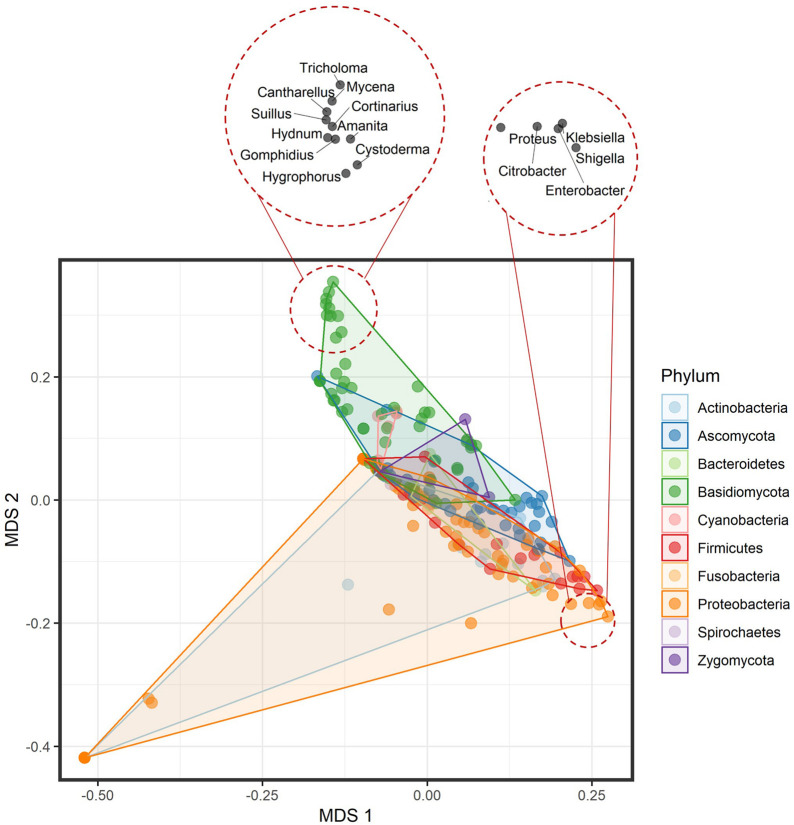
Multidimensional scaling plot of the volatilome profiles from bacterial and fungal genera differentiated at the phylum level. The top left corner shows the clustering of the Basidiomycota genera, while the bottom right shows the clustering of a few Proteobacteria genera.